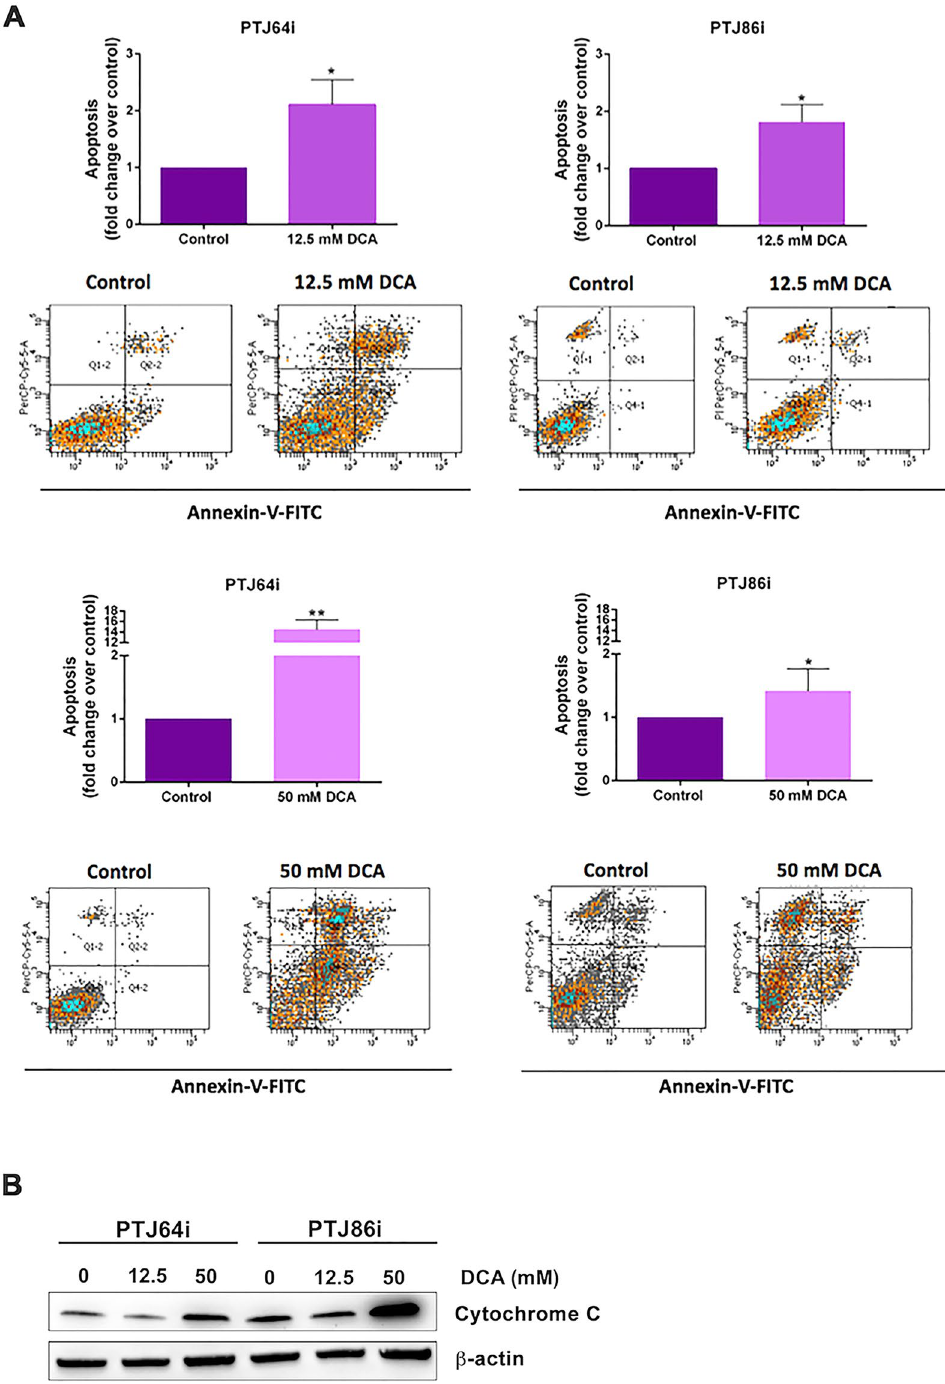
Figure 4. Apoptosis in PTJ64i and PTJ86i cells treated with 12.5 or 50 mM DCA. (A) Values represented in the histograms ( top of each panel ) are the means ± SD of two to six independent experiments ( * p < 0.05; *** p < 0.001). Dot plots ( bottom of each panel ) show representative experiments after a 24-hour treatment with 12.5 or 50 mM DCA; (B) Expression of cytochrome C in PTJ64i and PTJ86i cells treated with 12.5 and 50 mM DCA for 8 hours was analyzed by western blot. Full-length western blots are included in Supplementary Information (Fig.